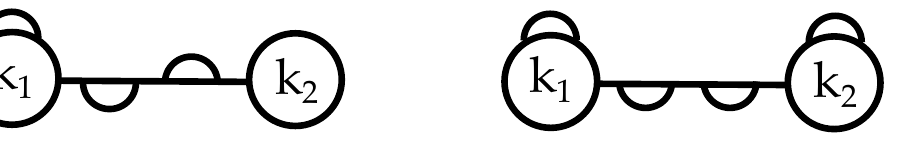
Figure 4 . Quiver description of Lens space quiver b T [(cid:10) ; G ], where p=q = k 1 (cid:0) 1 =k 2 and the [ k 1 ;k 2 ] dictionary in (2.23) is used. On the left we use the T ( G ) theory, and on the right the FT ( G ) theory, which is related by (cid:13)ipping an adjoint (cid:12)eld. This (cid:13)ipping operation can be represented pictorially by contracting an upward arc on a node and an adjacent downward arc on an edge to leave an upward arc on the edge. Further equivalent descriptions of this theory are shown in (cid:12)gure 5 below. Using the delta functions we can integrate out V 2 and V 3 after which two adjoints with opposite charge cancel. After these